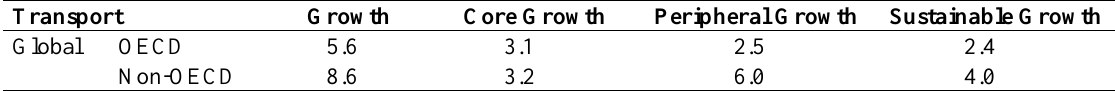
Table 9. Average annual growth in volume of trade between 1995 and 2020 (in %) Transport Growth Core Growth Peripheral Growth Sustainable Growth Global